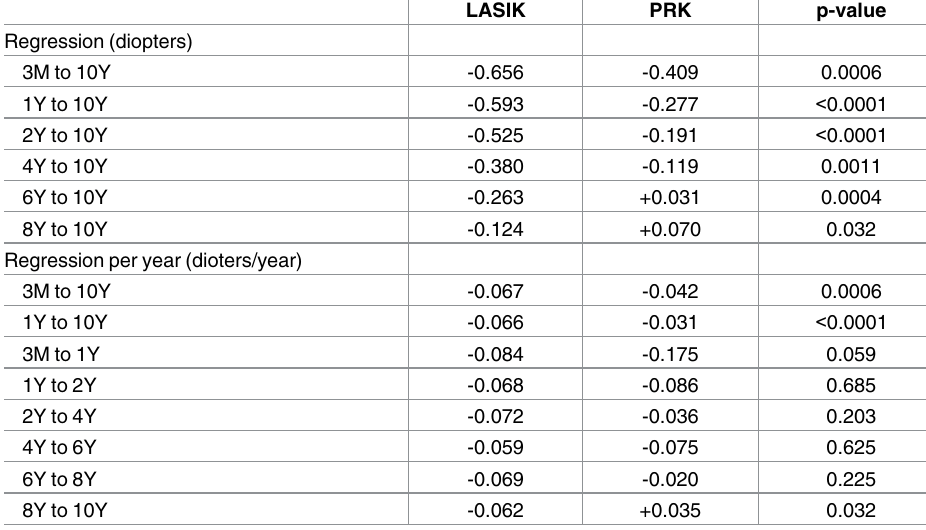
Table 2. Mean values of regression and regression rates after LASIK and PRK. LASIK